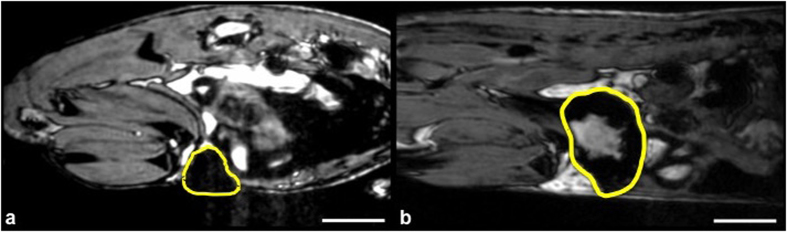
Iron-based MRI cell tracking.Sagittal bSSFP images of mammary fat pad tumors acquired 24 hours post USPIO administration. (a) 4 days post 4T1 cancer cell injection: Signal loss encompasses the entire tumor volume (b) 3 weeks post 4T1 cancer cell injection: The tumor is larger; signal loss is now seen around the periphery of the tumor and not within the central core. Scale bars represent 5 mm.